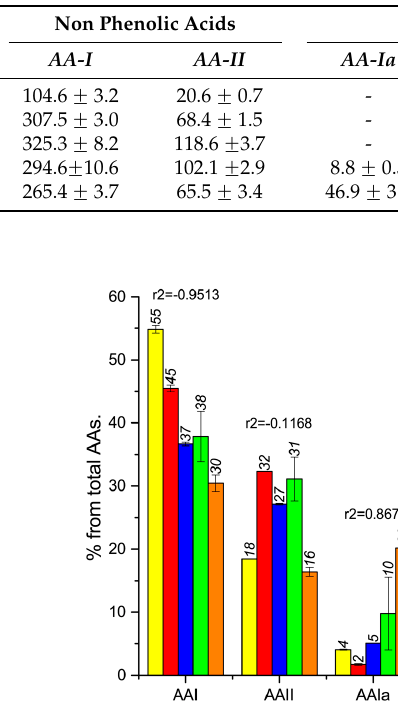
Table 2. Content (mg/kg, X ± SD) of AA-I ( 1 ), AA-II ( 2 ), AA-Ia ( 3 ), AA-IIIa ( 4 ) and AA-IVa ( 5 ) from samples of stems of A. chilensis collected between October and December 2014.